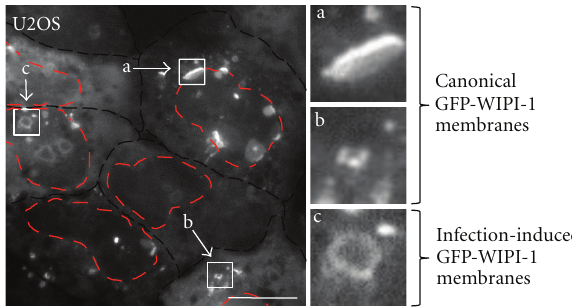
Figure 2: GFP-WIPI-1 images upon infection of U2OS cells with S. aureus HG001. GFP-WIPI-1 U2OS cells were infected with S. aureus HG001 in DMEM/FCS for 2h and images were automatically acquired. GFP-WIPI-1 fluorescence of the cells (indicated with the black- dashed line) is shown, and cell nuclei are indicated (red-dashed line) according to DAPI staining (not shown). Highlighted are the di ff erent GFP-WIPI-1 structures observed: large perinuclear GFP-WIPI-1 positive membranes (a) and cytoplasmic GFP-WIPI-1 puncta (b), reflecting canonical autophagosomal membranes. In addition, GFP-WIPI-1 positive autophagosomal-like vesicles appeared specifically upon infection (c). Scale bars: 20 μ m. Supplementary information is provided (Supplementary Figure 1).